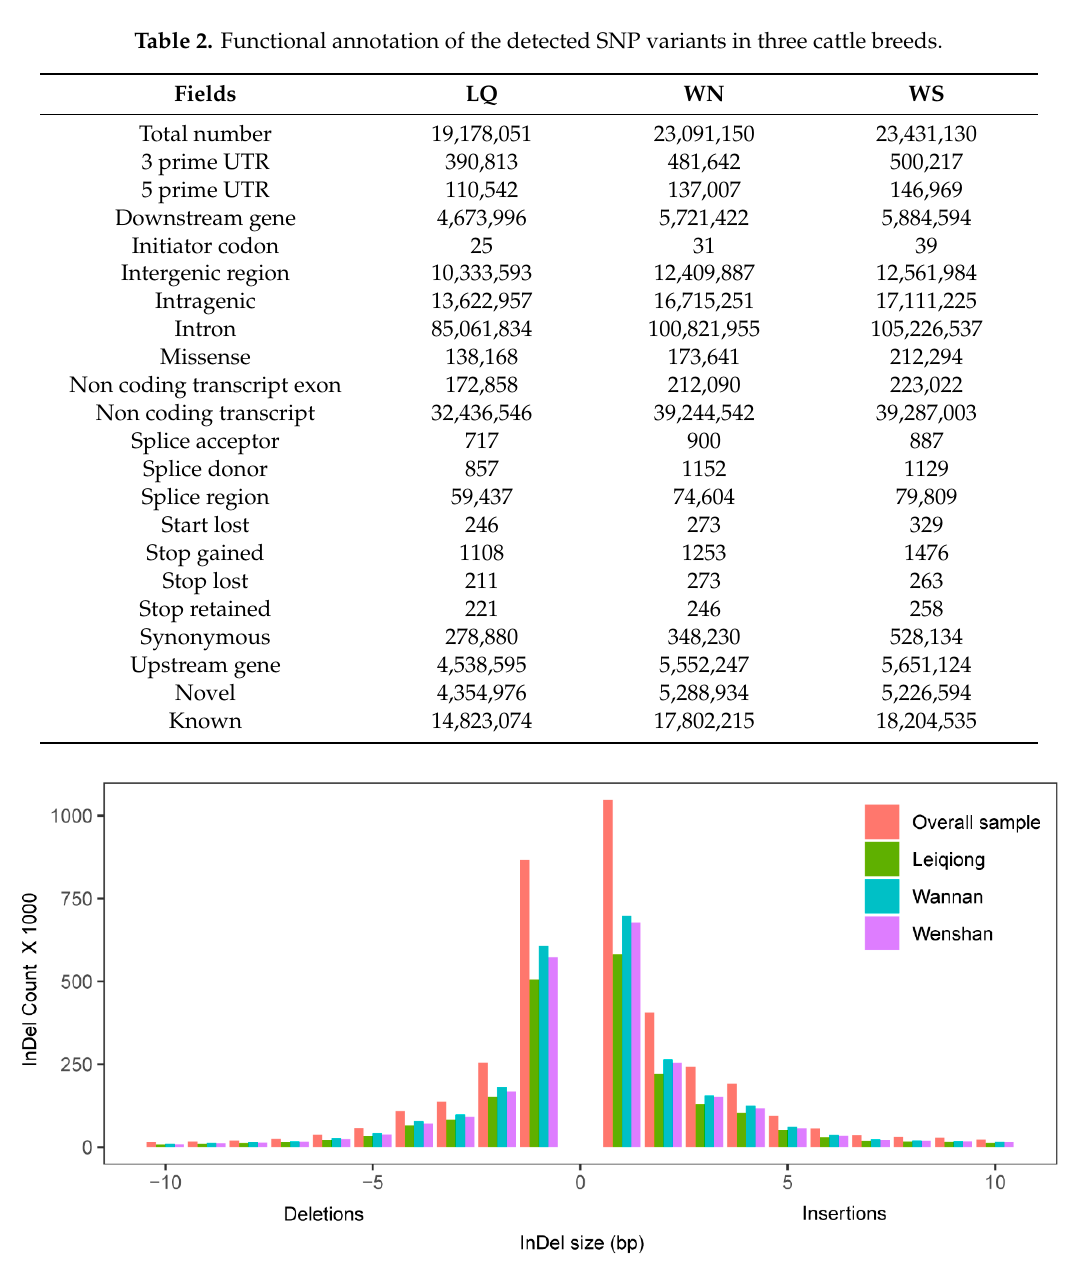
Figure 1. Distribution of insertions and deletions length in all InDels.